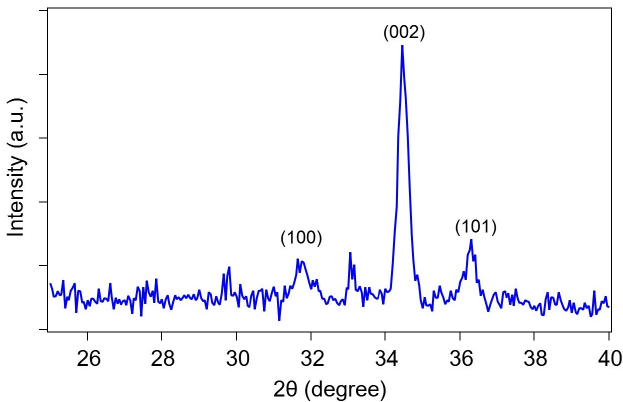
Figure 4. X-ray diffraction pattern of Al-doped ZnO nanorods on the microcantilever surface using a Rigaku Ultima-III X-ray diffractometer with CuK radiation ( λ = 0.15418 nm) operated at 40 kV and 40 mA. The strong (002) peak indicates that the ZnO growth direction tends to be oriented along the vertical axis.